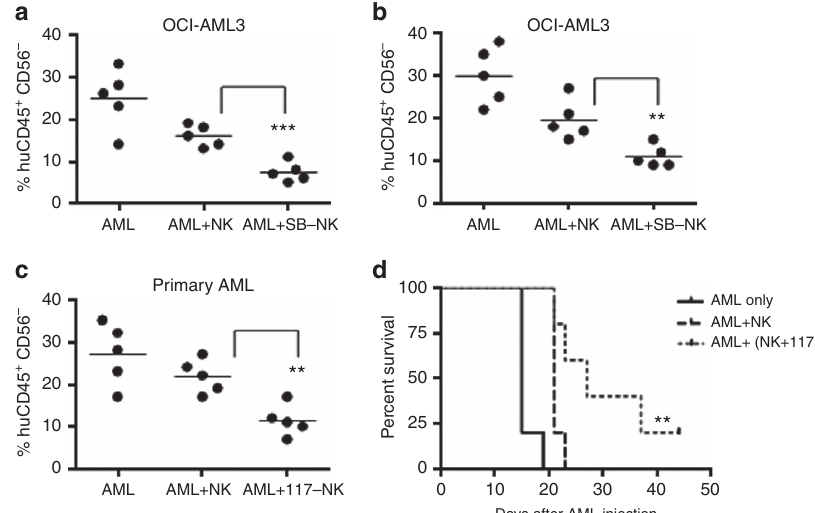
Figure 7 | GSK3-inhibited NK cells show high activity in AML mouse model systems. ( a , b ) NSG mice were injected with OCI-AML3 cells followed by weekly injections of vehicle, expanded NK cells, or expanded NK cells that were pre-treated with SB for 16h. The per cent human AML cells (CD56 (cid:2) CD45 þ ) were detected by flow cytometry from ( a ) spleen and ( b ) bone marrow after 6 weeks ( c ) NSG mice were injected with primary AML cells followed by weekly injections of vehicle, expanded NK cells, or expanded NK cells that were pre-treated with compound 117 for 16h. The per cent human AML cells (CD56 (cid:2) CD45 þ ) were detected by flow cytometry from the bone marrow after 5 weeks. (unpaired Student’s t -test *** P o 0.001, ** P o 0.01). ( d ) NSG mice were injected with primary human AML cells followed by four (bi-weekly) injections of vehicle, expanded NK cells or expanded NK cells pre-treated with compound 117 for 16h. Kaplan–Meier survival curves of mice are shown. w 2 log-rank test was performed for statistical significance. ** P o 0.01 for AML þ NK versus AML þ (NK þ 117) groups. Experiments is performed two times. In all mice experiments, five mice per group were